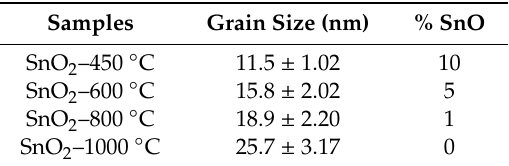
Figure 1. X-ray diffraction patterns for samples of tin oxide (SnO 2 ) annealed at 300, 450, 600, 800, and 1000 °C for 1 h. Table 1. Grain sizes of SnO 2 particles.